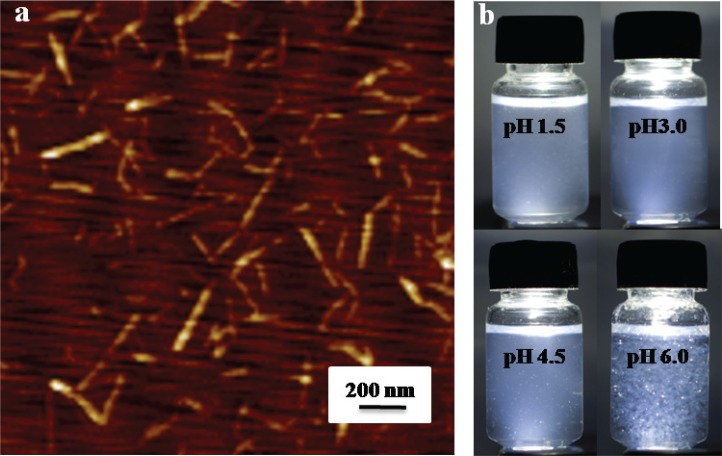
Characterizations of partially deacetylated α-chitin nanofibers: (a) atomic force microscopy observation of partially deacetylated α-chitin nanofiber/nanowhisker mixtures (DEChNs) prepared from α-chitin; (b) photographs of dispersions of DEChNs in water at pH 1.5–6.